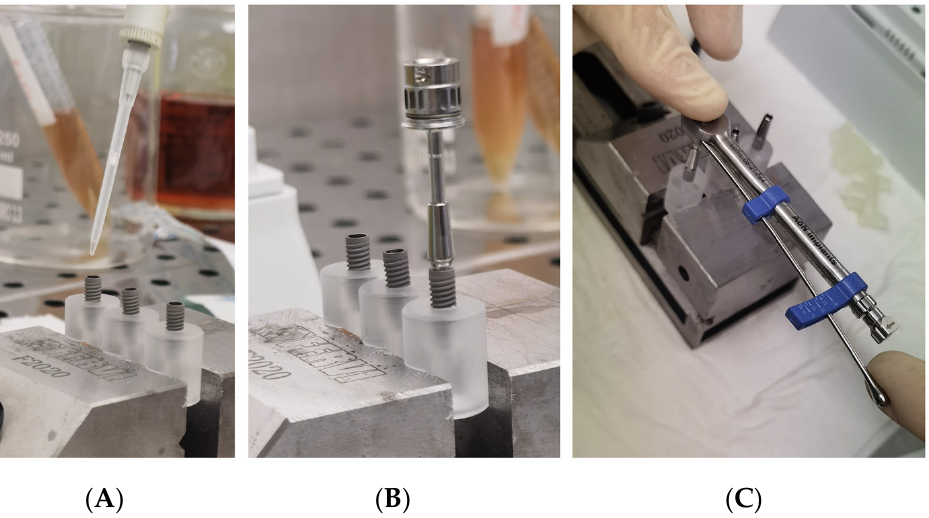
Figure 4. ( A ) Inoculation of the inner part of implants with 1.0 µ L of viable bacterial; ( B ) An implant- abutment connection assembled with a manual rachet; ( C ) An implant-abutment connection assem- bled with a manual ratchet and the dynamometric measurement of the torque.